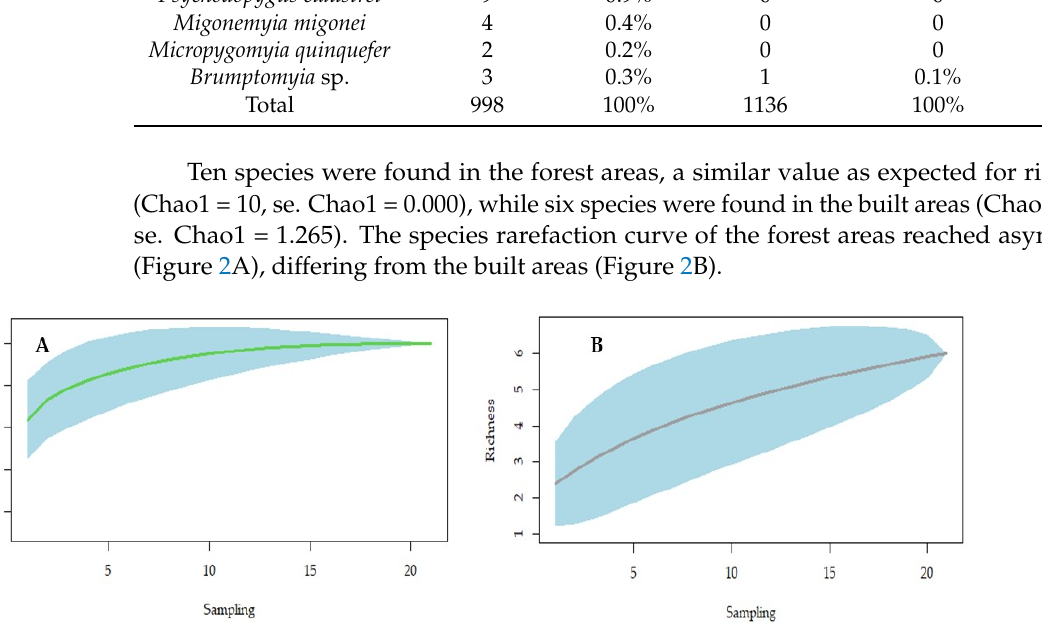
Table 3. Bioindicator species analysis of sand flies in the forest areas and in the built areas of João Pessoa, Paraíba, Brazil.